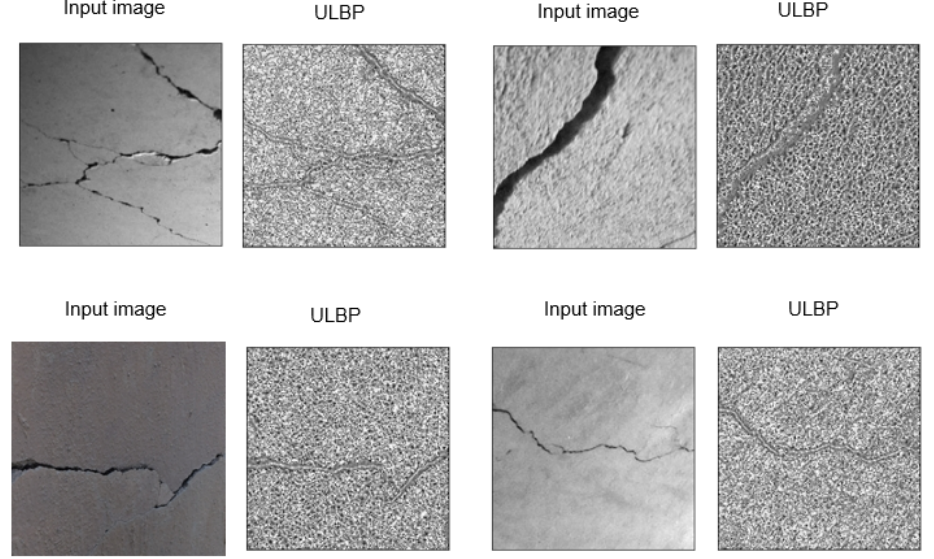
Figure 2. ULBP features of concrete crack images from [25].